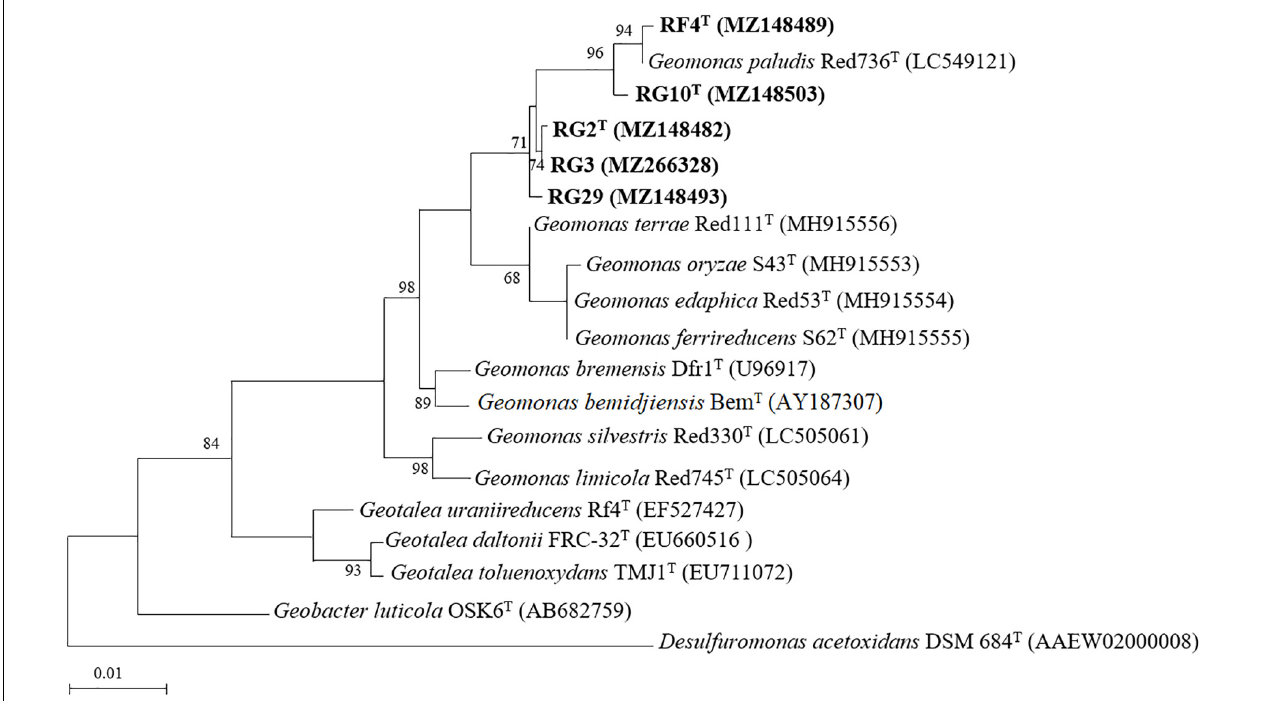
FIGURE 1 | Maximum-likelihood phylogenetic tree based on 16S rRNA gene sequence of five isolated strains and their closely related type strains. Bootstrap values (expressed as percentages of 1,000 replications) greater than 50% are shown at branch points. Bar, 0.01 substitutions per nucleotide position. Desulfuromonas acetoxidans DSM 684 T is used as an outgroup. Number in the parenthesis is the GenBank accession number.